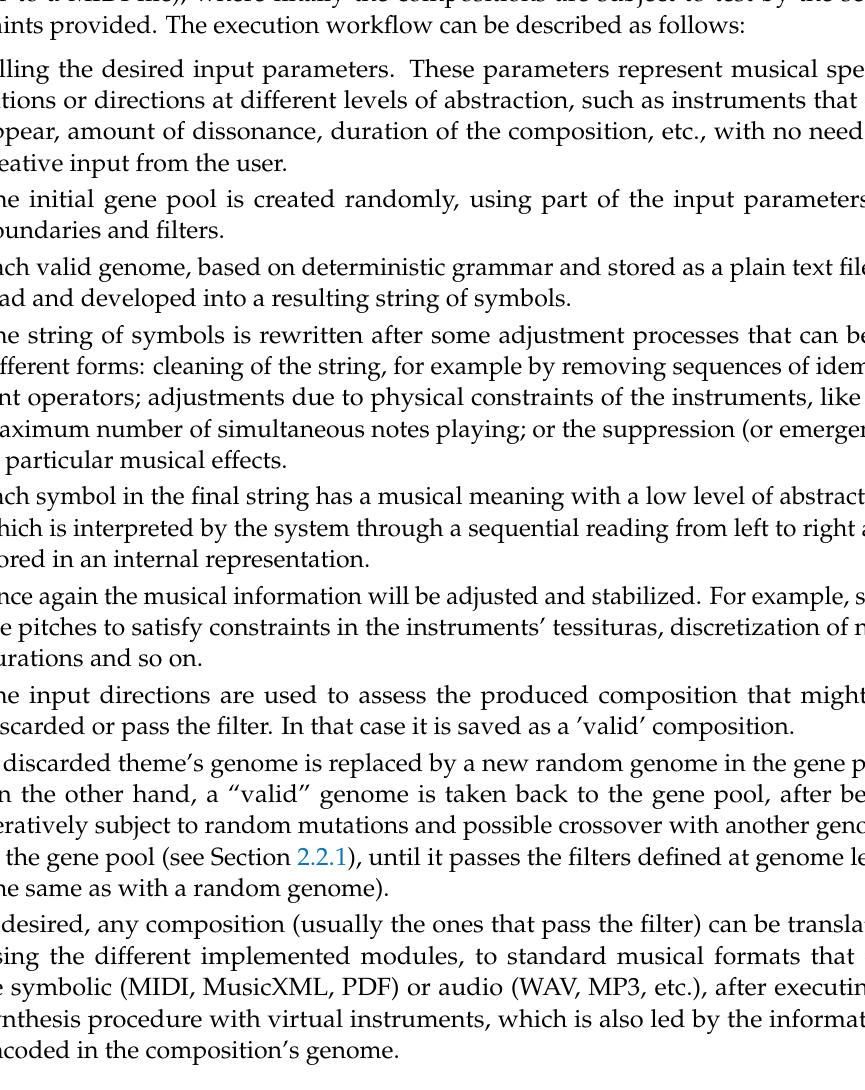
style, symphonic orchestra in the atonal system, the process takes 283 s on average. Given a built gene pool, the time to obtain a new valid composition, which includes executing the developmental process possibly repeatedly until passing the filters, varies a lot too. It can take 6 s for the simplest atonal style, while it takes 368 s on average for the most complex style in the tonal